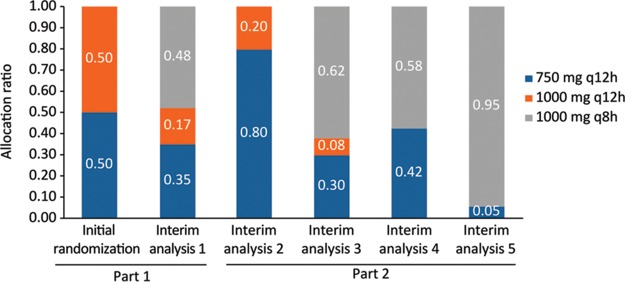
Adaptive randomization allocation ratios over time following each interim analysis (all-randomized population). The initial randomization bar represents part 1 of the study, where there was 1:1 randomization allocation to the 750-mg q12h and 1,000-mg q12h treatment groups. Interim analysis 5 represents the randomization allocation should the study have continued further.